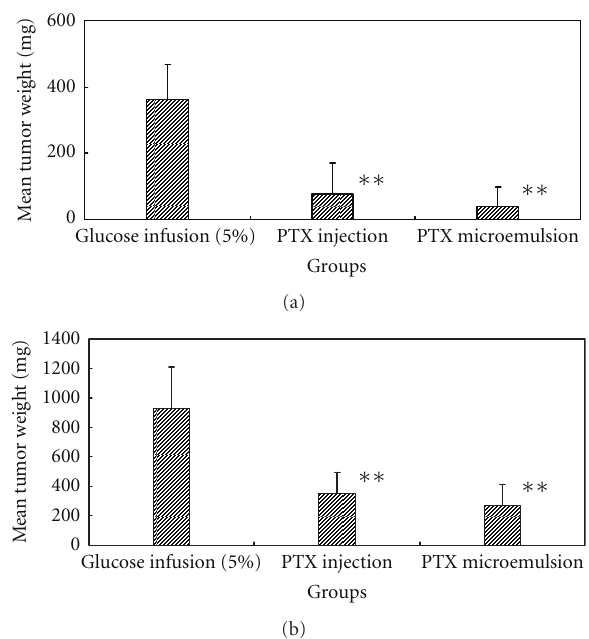
Figure 5: The mean tumor weight in the 5% glucose infusion, PTX injection and PTX microemulsion groups at day 33 after OVCAR- 3 cell implantation (a) or A-549 cells (b) at day 32 after A 549 cell implantation. Results are given as means ± S.D. ( n = 6). ∗∗ P < . 01 versus 5% glucose infusion as